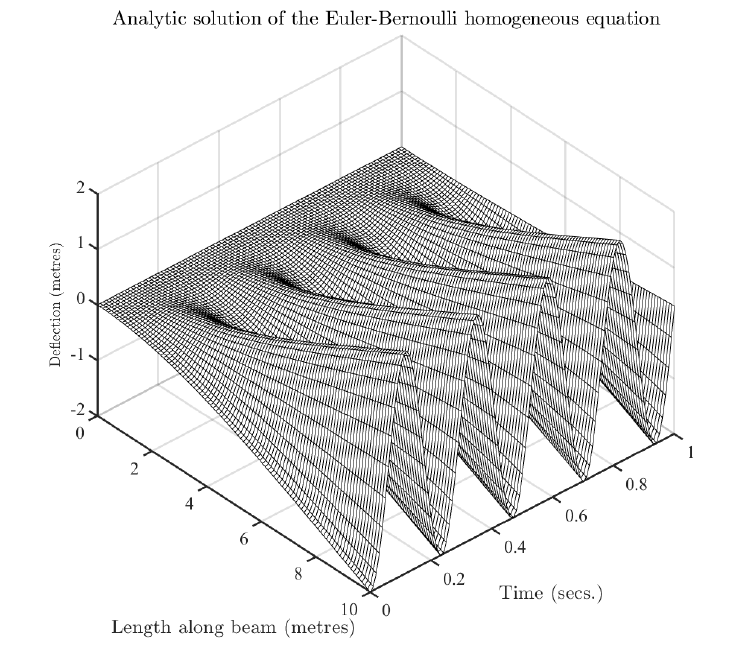
Figure 8. Analytical solution of the Euler–Bernoulli homogeneous equation for a 10-m cantilevered beam in free vibration.